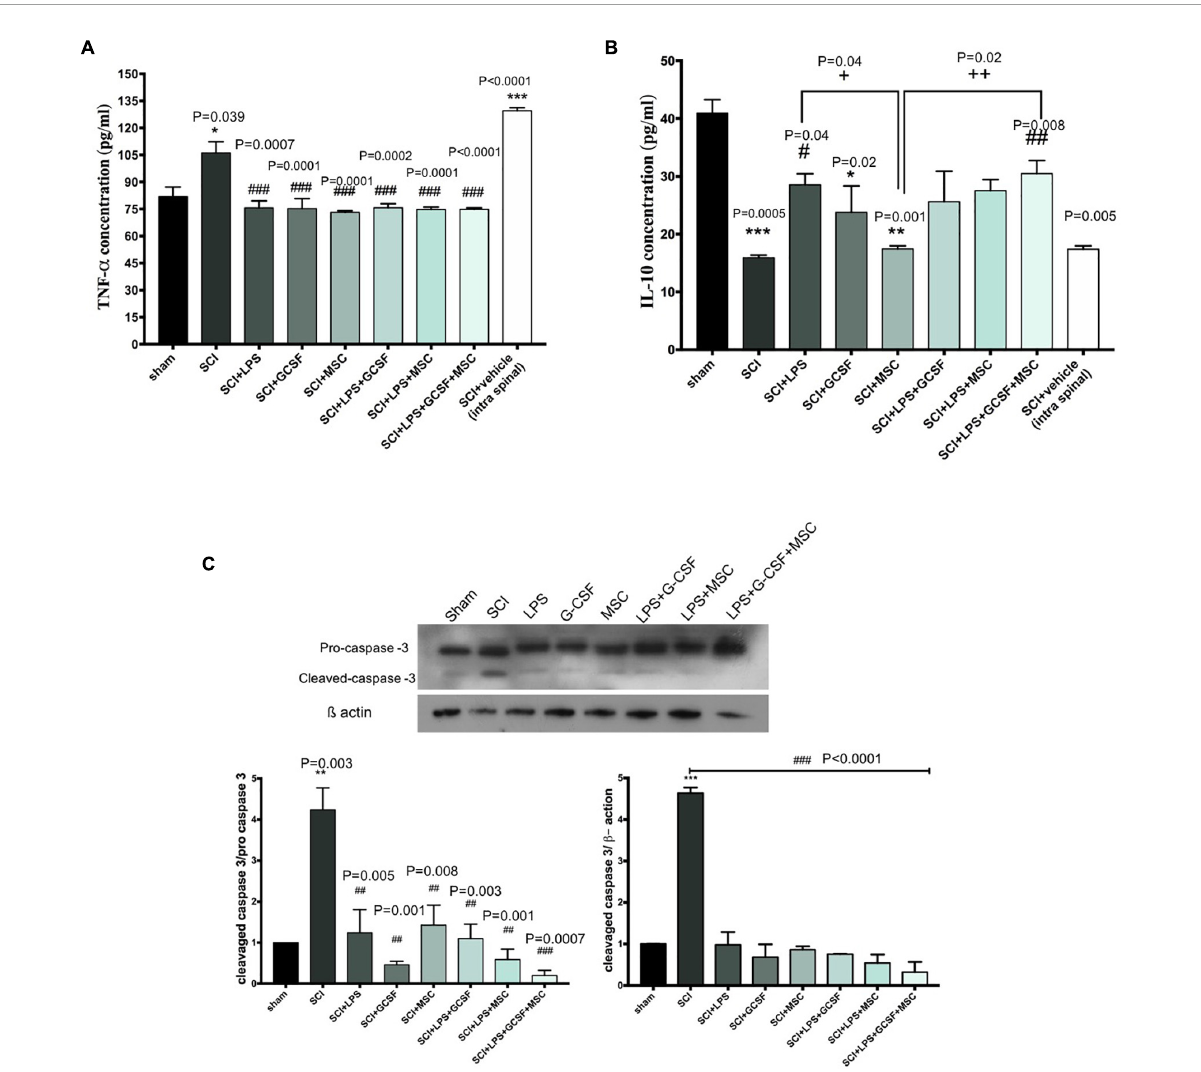
FIGURE7 Combination therapy regulates inflammatory cytokine levels and prevents apoptosis in the spinal cord at 7 days post-SCI. (A) Levels of TNF- α , (B) level of IL-10 in the spinal cord were detected by ELISA on day 7 after the sham operation ( n = 3/group). # P < 0.05, ## P < 0.01 versus SCI, + P < 0.05, ++ P < 0.01 versus MSC. (C) The protein expression level, determined by Western blot analysis, in the injured spinal epicenter of SCI rat at 7 dpi. Data are presented as mean ± SEM, * P < 0.05, ** P < 0.01, and *** P < 0.001 versus sham. # versus SCI or vehicle. One-way analysis of variance (ANOVA) variance followed by Tukey’s post-hoc